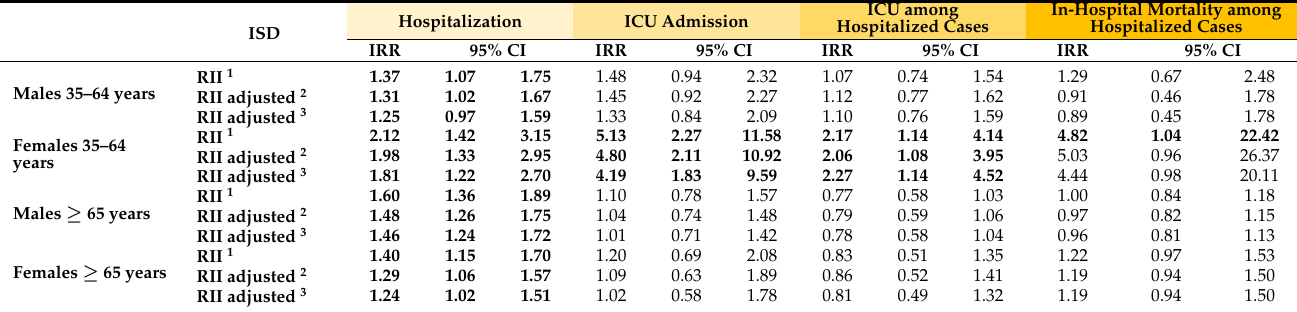
Table A4. Relative Index of Inequality (RII) about incidence of hospitalization and ICU admission, risk of ICU admission, and in-hospital mortality among hospitalized people for the individual Index of Socioeconomic Disadvantage (ISD), by gender and age group.